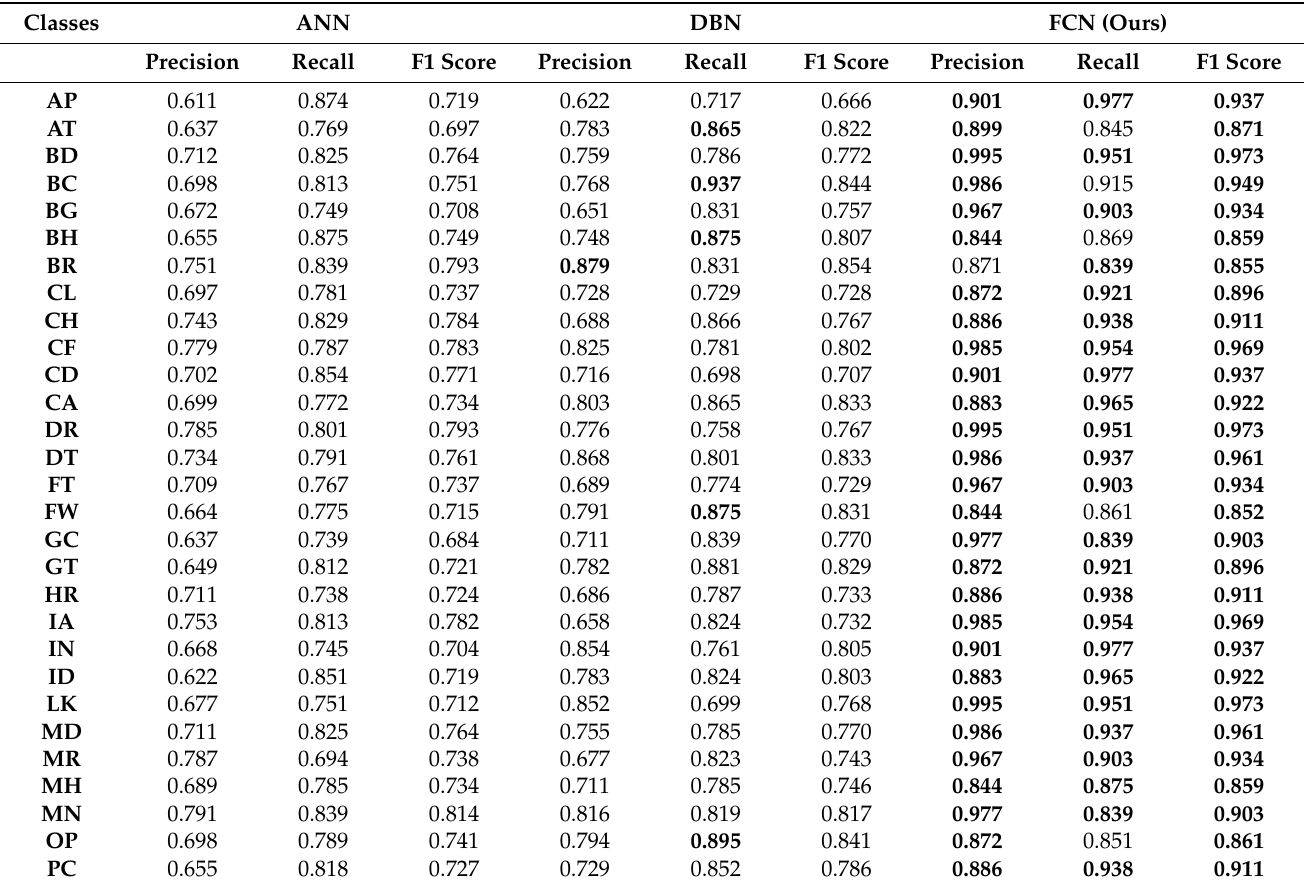
Table 3. Scene classification results against three classifiers on RESISC45